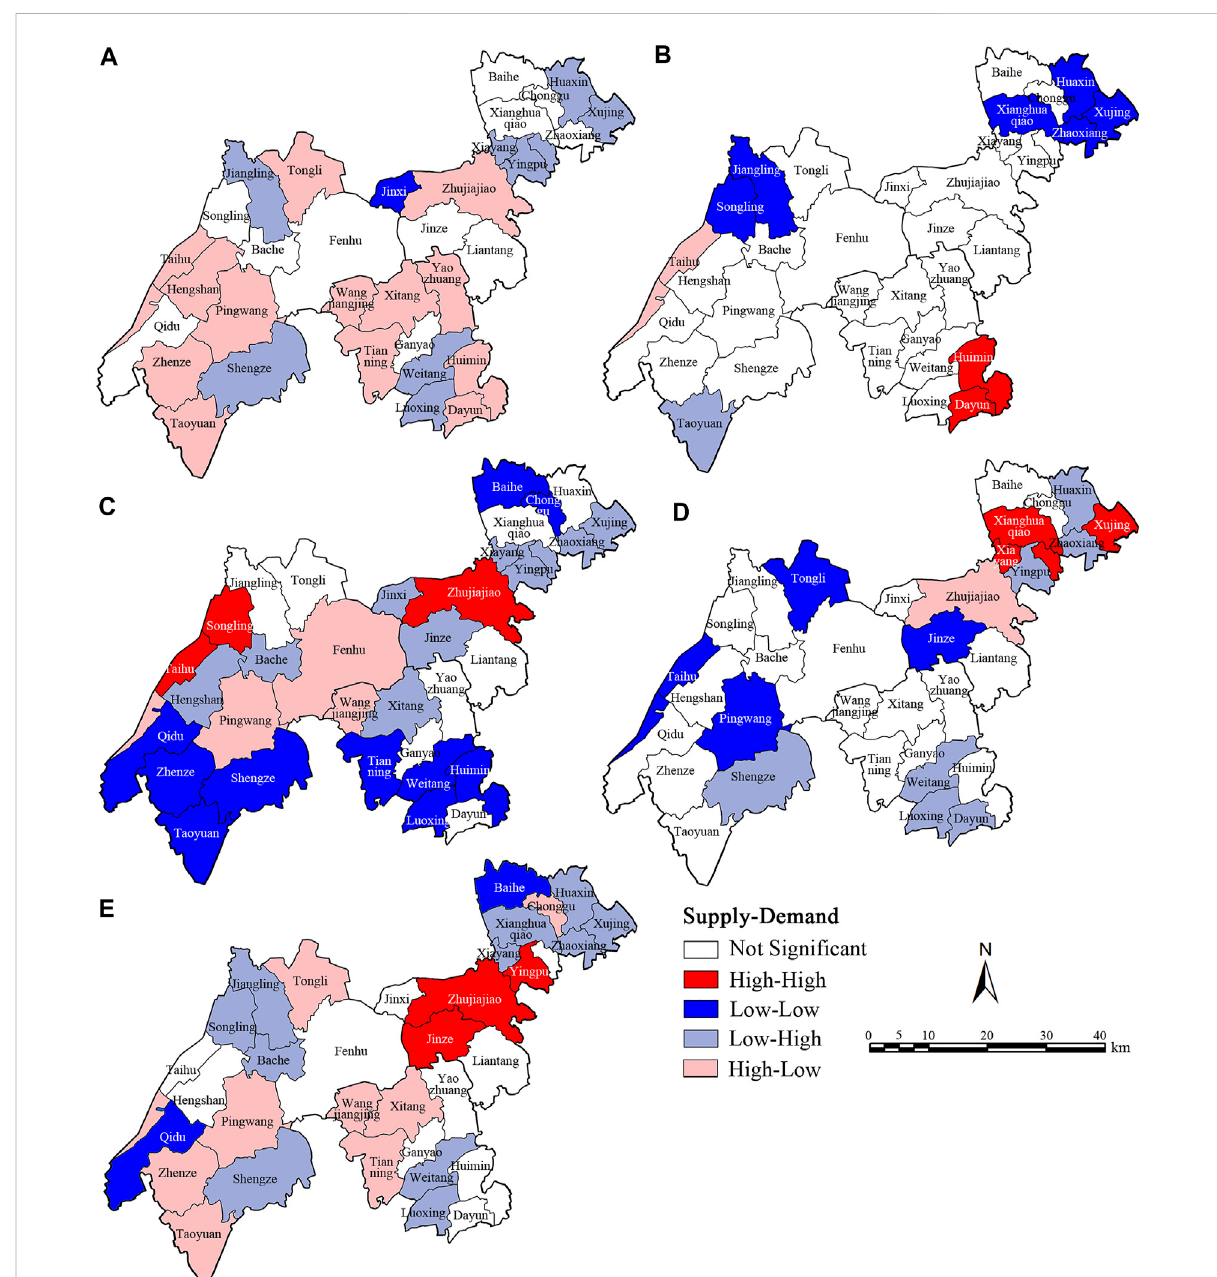
FIGURE 4 Bivariate LISA cluster maps of the matching patterns of ES supply – demand in the study area. (A) Provisioning service; (B) regulating service; (C) supporting service; (D) cultural service; (E)